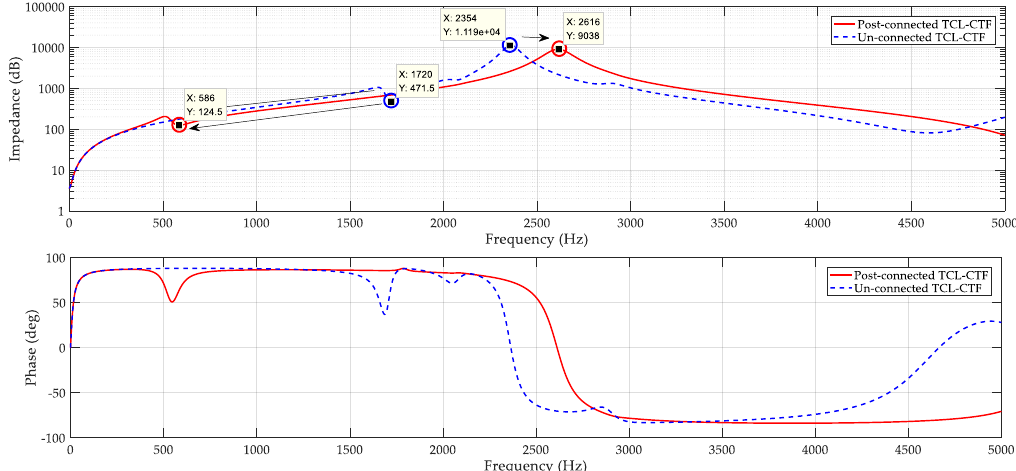
Figure 10. Bode diagram of the traction power supply system (TPSS) with the TCL-CTF.